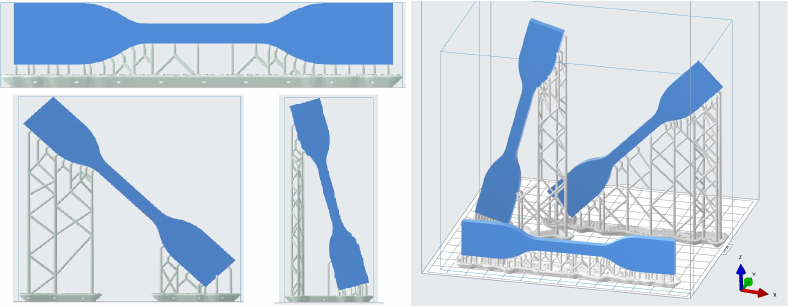
Figure 2. Printing angle variation in tensile coupons. The images correspond to the printing software simulations; the specimens are filled with blue and the supports in